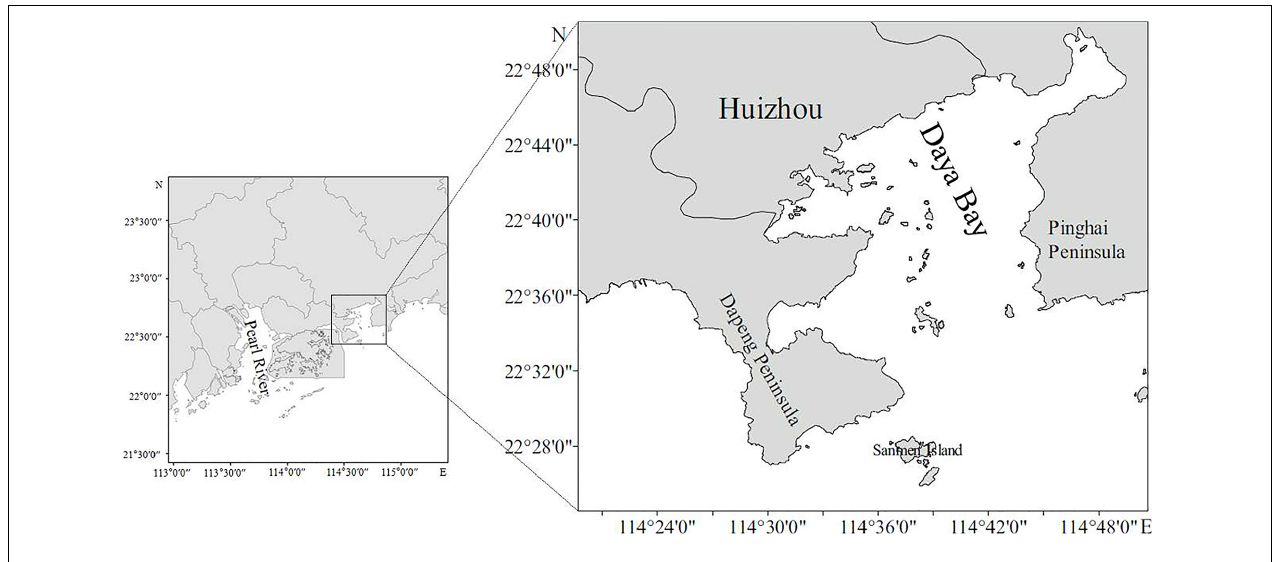
FIGURE 1 | The sampling station in Daya Bay.